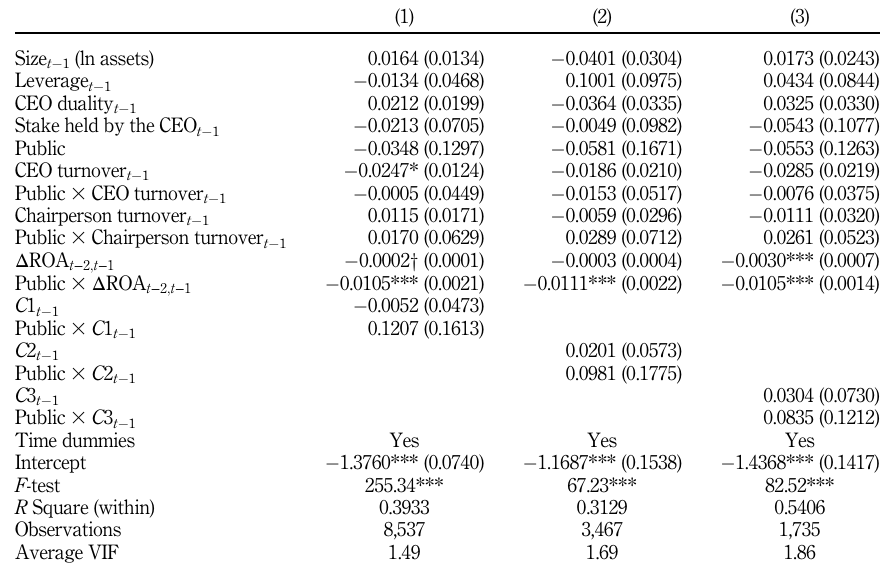
Table 5. CEO turnover: the alignment of large shareholders (full